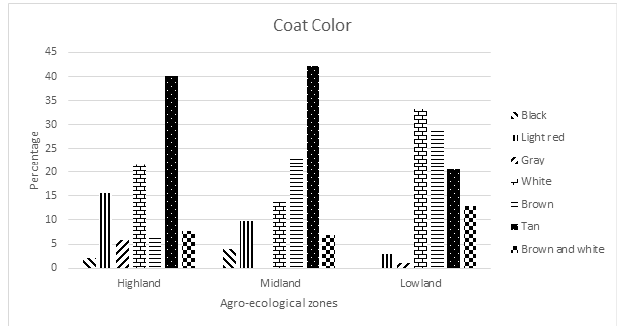
Figure 5. Coat color of sheep populations from different agro-ecological zones; significant (p < 0.0001) effect of agro- ecological zones was observed over the coat color of the studied sheep populations.